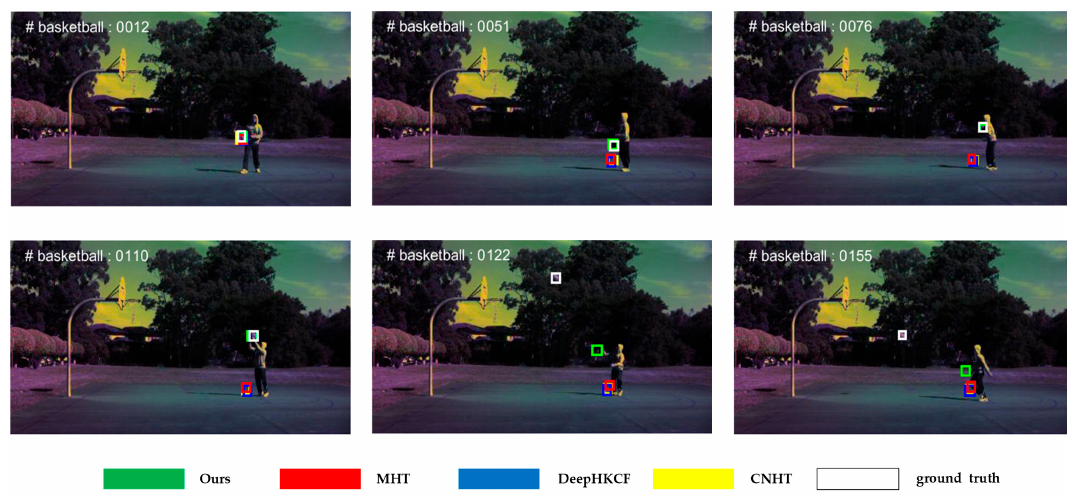
Figure 9. Tracking result of the basketball sequence.